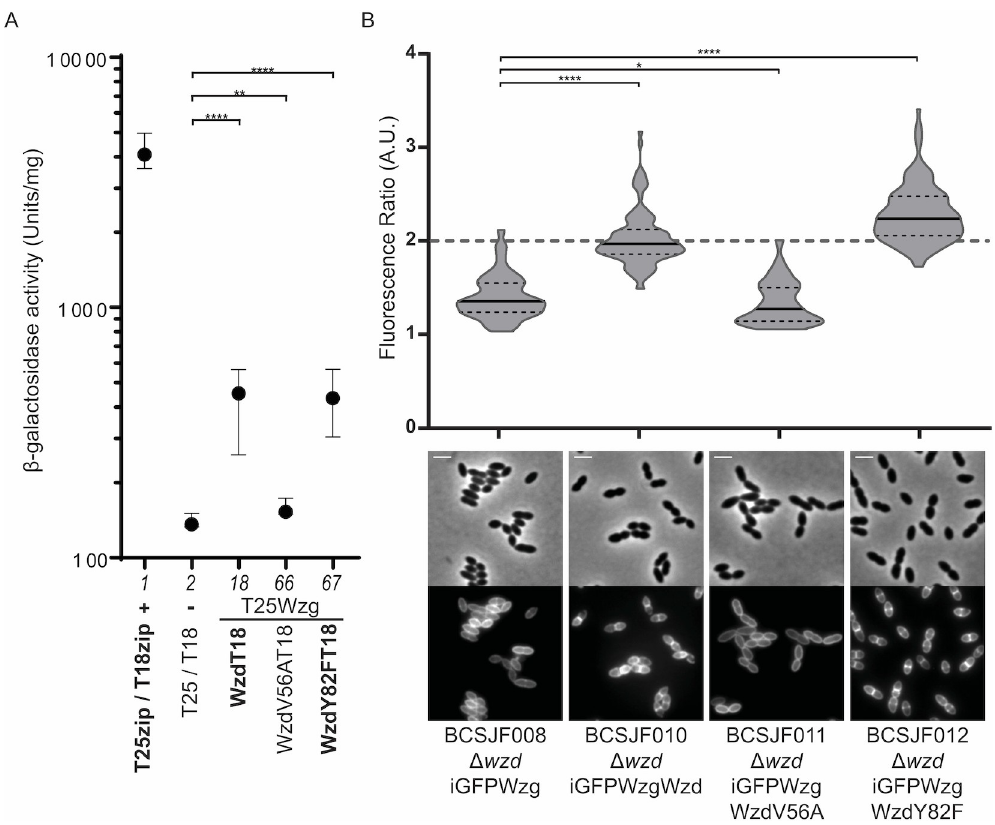
Fig 5. The valine residue at position 56 of Wzd is required for its interaction with Wzg, and for the recruitment of Wzg to the division septum. A) Interaction between Wzg and Wzd, WzdV56A and WzdY82F point mutants was tested by BTH. Black circles indicate median values and brackets show the 25% and 75% percentiles of β -galactosidase activity measured in cell extracts of at least three independent replicates. Positive control (+): E . coli expressing T18 and T25 fragments linked to leucine zipper domains (zip) that can dimerize; Negative control (-): E . coli expressing untagged T18 and T25 fragments. WzdV56A-T18 lost the ability to interact with T25-Wzg. B) Graph shows the ratio of iGFP-Wzg fluorescence measured at the septum versus the peripheral wall in the S . pneumoniae wzd null mutant strain (BCSJF008, n = 107) and in the wzd null mutant strain expressing Wzd or Wzd point mutants from a constitutive promoter (non-mutated Wzd strain BCSJF010, n = 109, mutant WzdV56A strain BCSJF011, n = 106, and mutant WzdY82F strain BCSJF012, n = 128). WzdY82F, but not WzdV56A, can recruit Wzg to the division septum of pneumococcal bacteria. � P � 0.05, �� P � 0.01, ���� P � 0.0001.